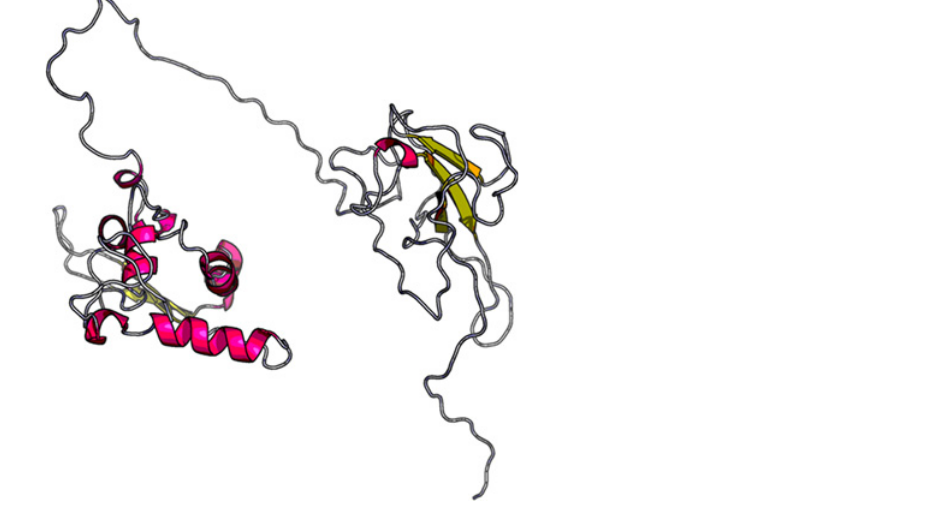
conformational B-cell epitopes having a Protrusion Index (PI) score value above 0.7 were 97.9% (PI score: 0.979) and shown in Fig 3A. Residues involved in conformational epitopes,